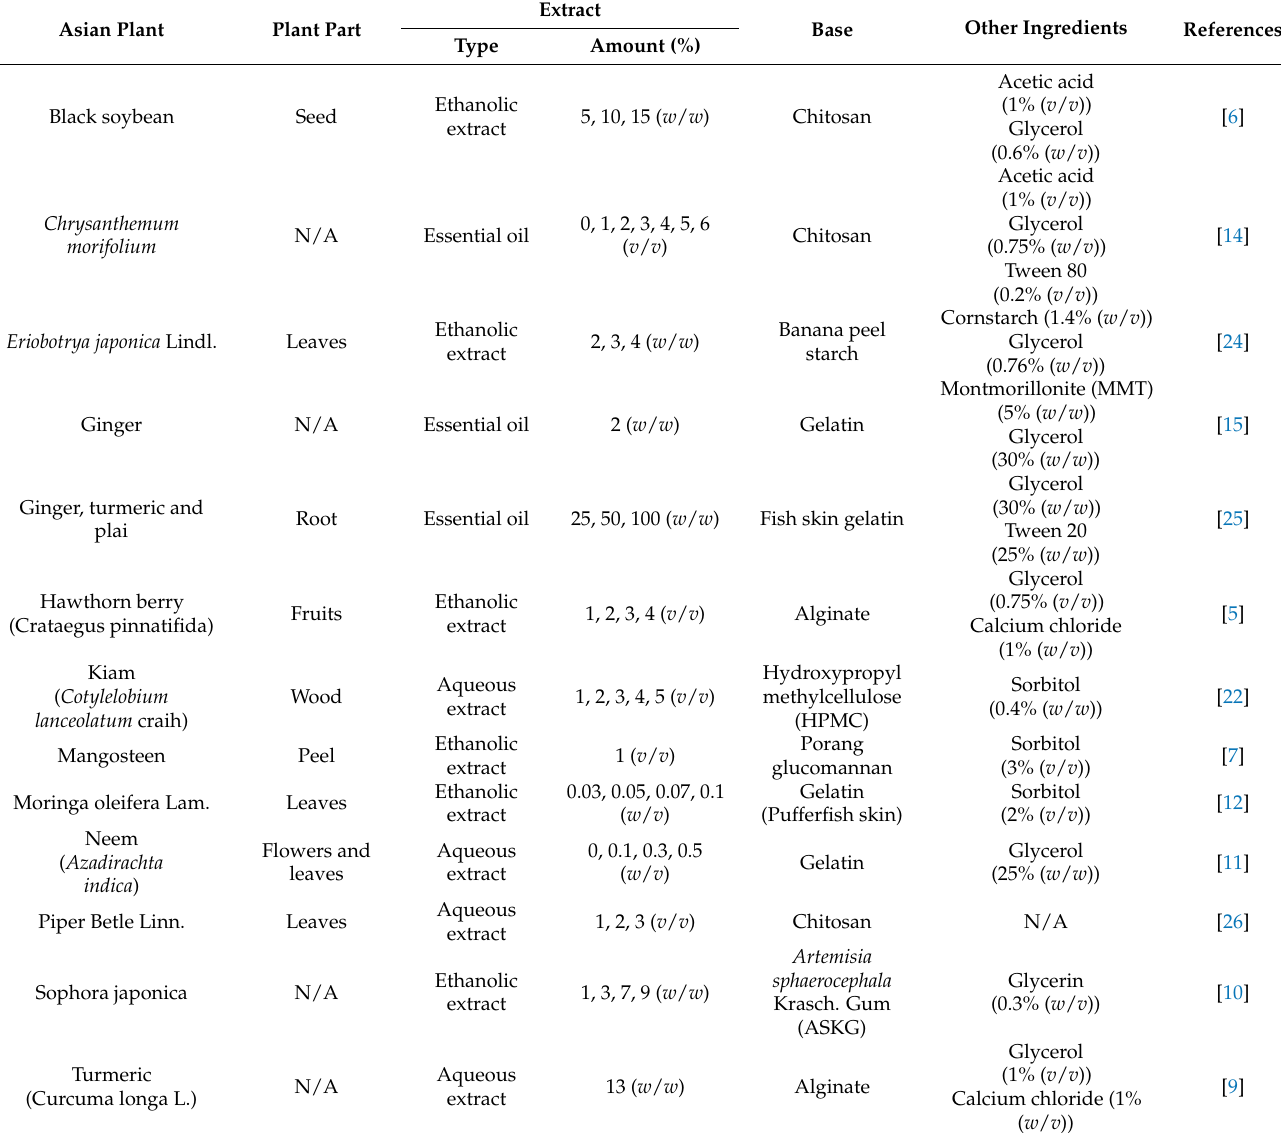
Table 1 lists examples of the various APE and EOs incorporation of EF. Table 1. Various APE and EOs incorporation of